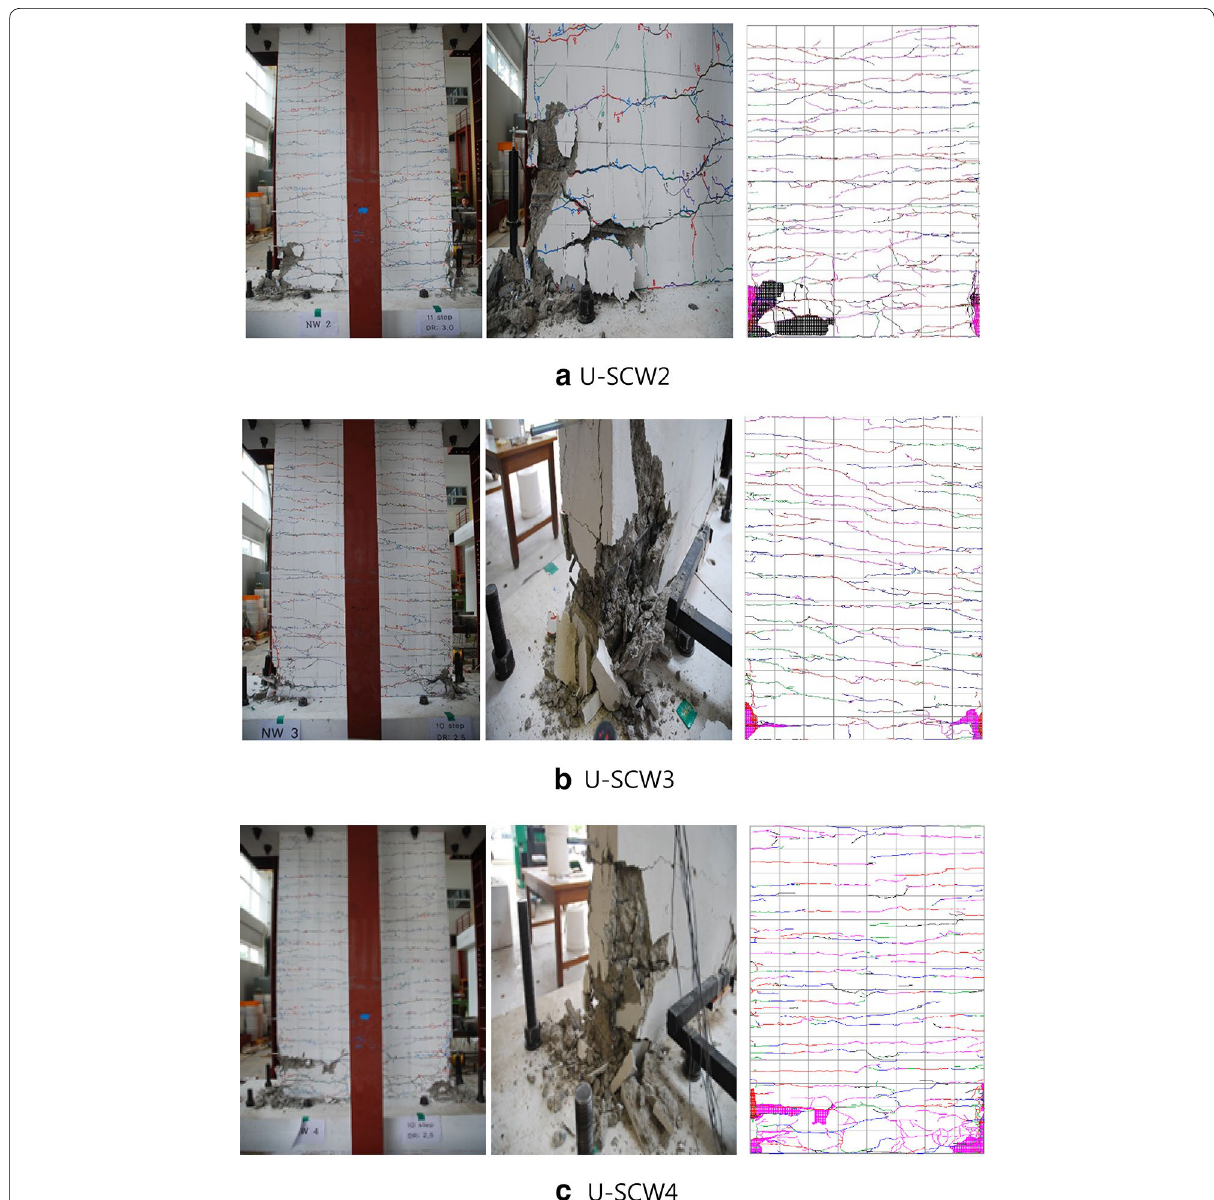
Fig. 11 Final cracks and damage